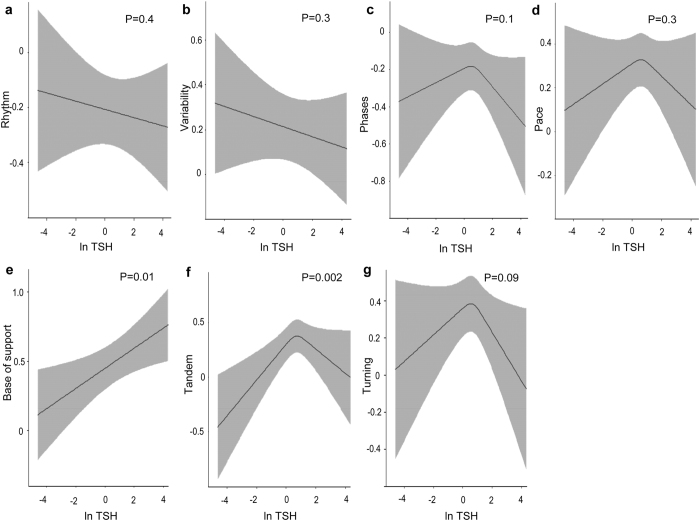
Association of TSH with the seven gait domains.Adjusted for age, sex, cohort, smoking, alcohol intake, education level, height, weight, time interval between thyroid function measurement and gait assessment, knee pain or stiffness, hip pain or stiffness, prevalent stroke, CESD depression score, cerebellar cortical volume, intracranial volume, thyroid peroxidase antibodies. The model including Tandem walk was additionally adjusted for step count and mean step size. Point estimates are reported as predicted means (black lines) of gait domains with 95% CI (gray areas). A higher value of gait domains represents better gait.